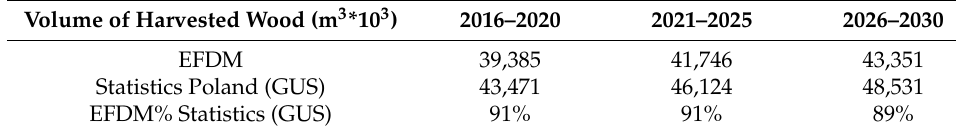
Table 6. Felling drain comparison received from EFDM.